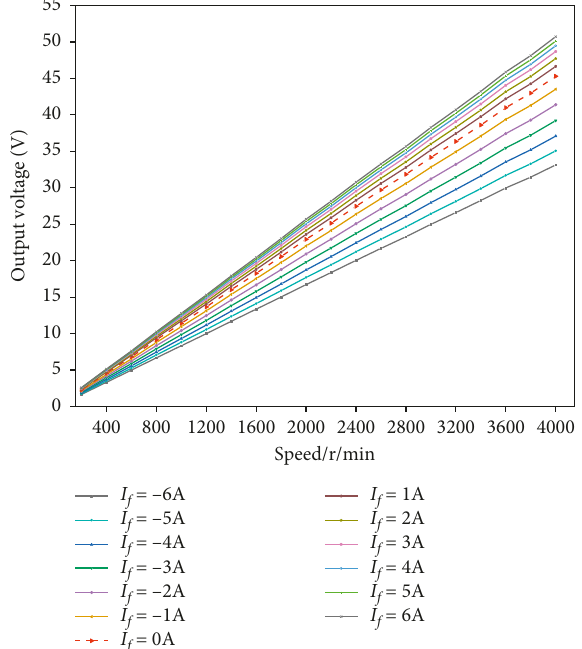
Figure 26: The no-load characteristic curve of HEG.